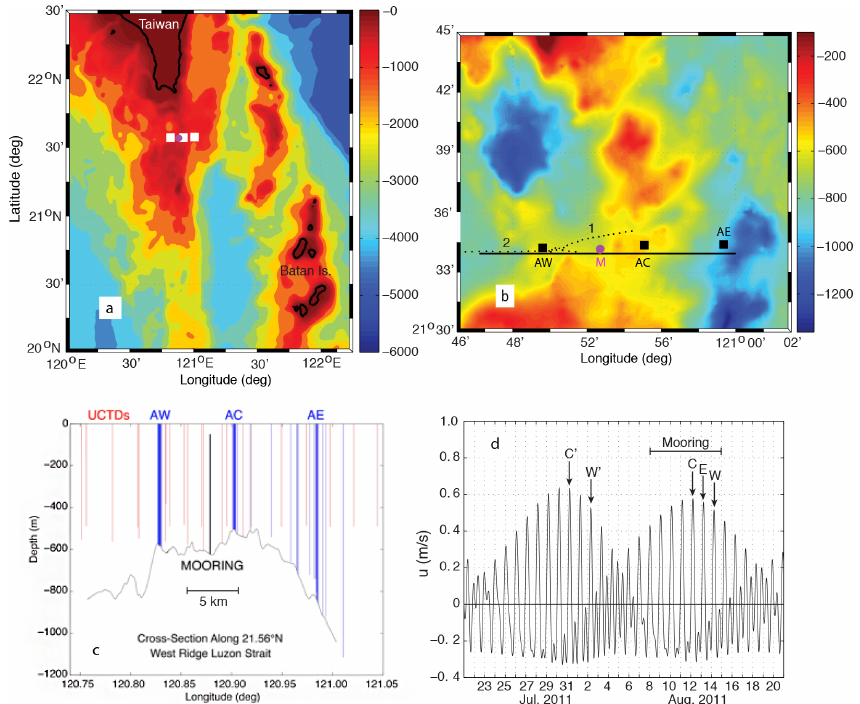
Figure 1. (a) Locator map showing the experiment site south of Taiwan; (b) a zoomed-in version of the plan view showing the local topography. Black squares indicate the 24h time series stations and the magenta dot is the mooring location. The small black dots indicate the UCTD stations along the two transects numbered 1 and 2. (c) A cross-sectional view of the transect shown by the black line in (b) . In both panels, the letters AW, AC, and AE indicate the locations of the 24h time series stations Anchor West, Anchor Center, and Anchor East, respectively. (d) The timing of the anchor stations with respect to the TPXO7.2 fortnightly tidal envelope. The letters C (cid:48) and W (cid:48) indicate times analogous to C and W where model output was extracted for